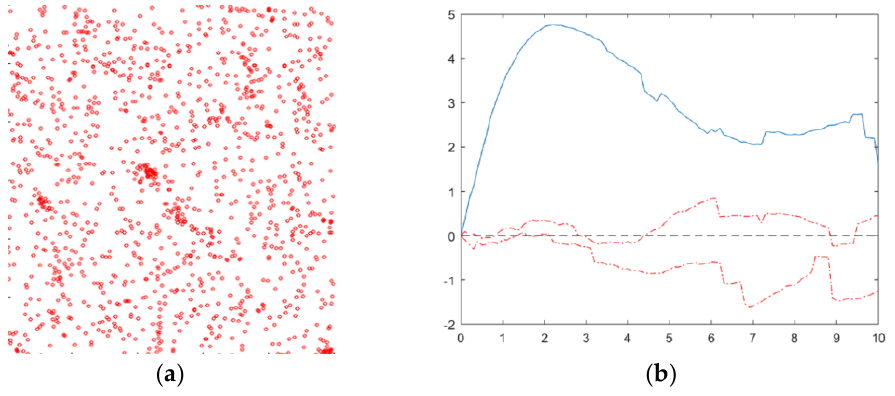
Figure 6. ( a ) Poisson random point process; and ( b ) L-function. In the L-function graph, the clustering is better illustrated, with a blue line (observed L-function) above the black dashed line corresponding the theoretical one; red dashed lines are the lower and upper limits for L-Function with L ( d ) = min (cid:26) (cid:95) (cid:27) and U ( d ) = max . Since the L-function lies above the upper limit, the clustering is